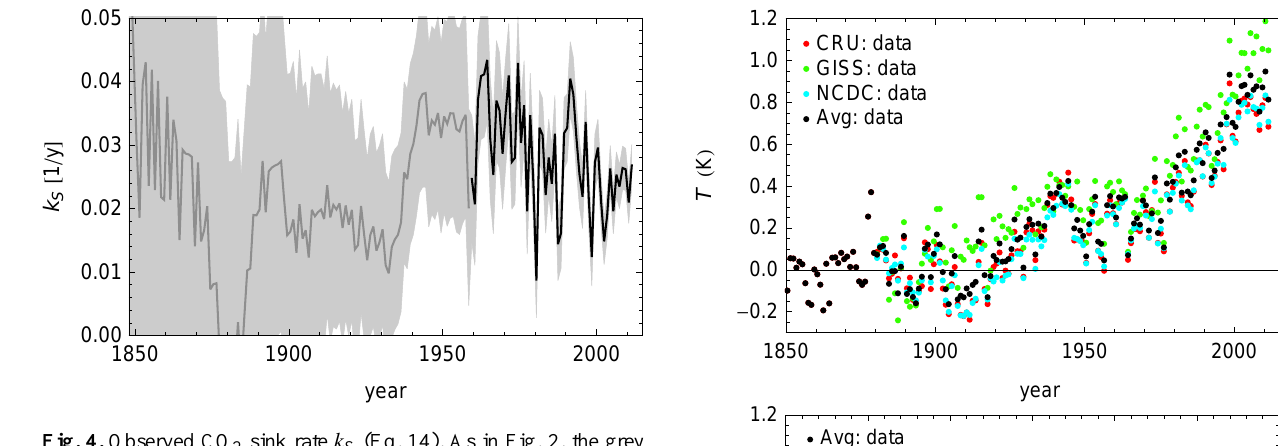
Fig. 4. Observed CO 2 sink rate k S (Eq. 14). As in Fig. 2, the grey band is an uncertainty estimate ( ± 1 σ ) accounting for errors in both CO 2 emissions and CO 2 concentration data, and full and semi- transparent lines respectively denote observations in the period of high-quality in situ atmospheric CO 2 estimates (from 1959 onward) and the period before 1959. Data sources: Appendix C.